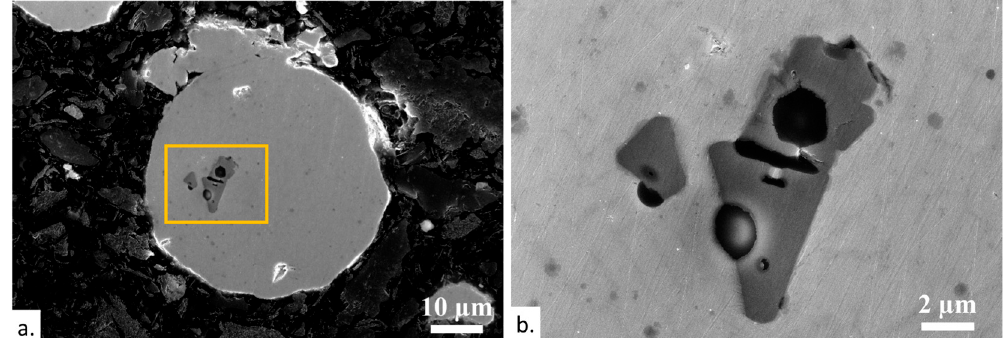
Figure 3. ( a ) SEM micrograph of the polished cross-section of the gas atomized Alloy 718 powder used as feedstock to produce the samples of this study. ( b ) Close-up on titanium nitrides and Al-rich oxides characterized by darker contrast.